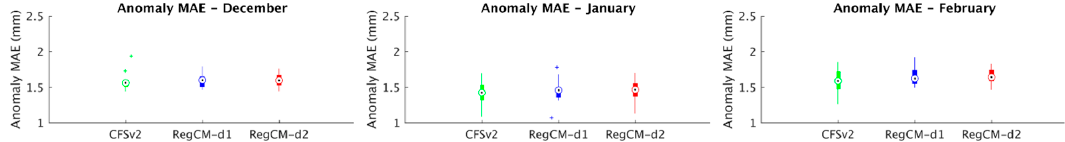
Figure 12. The same as in Figure 5 but for the precipitation.